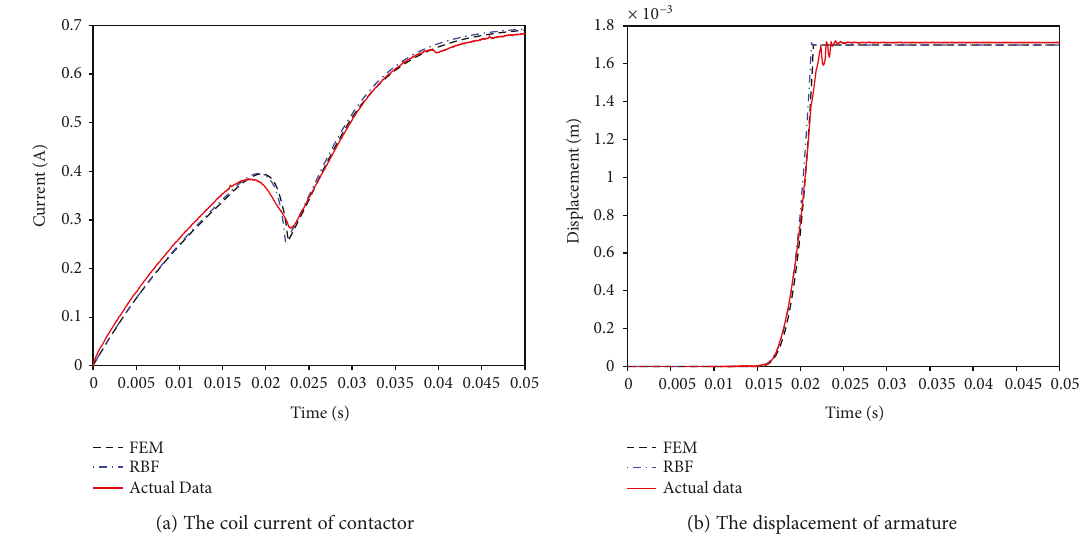
Figure 3: The comparison of the accuracy of the approximate model.